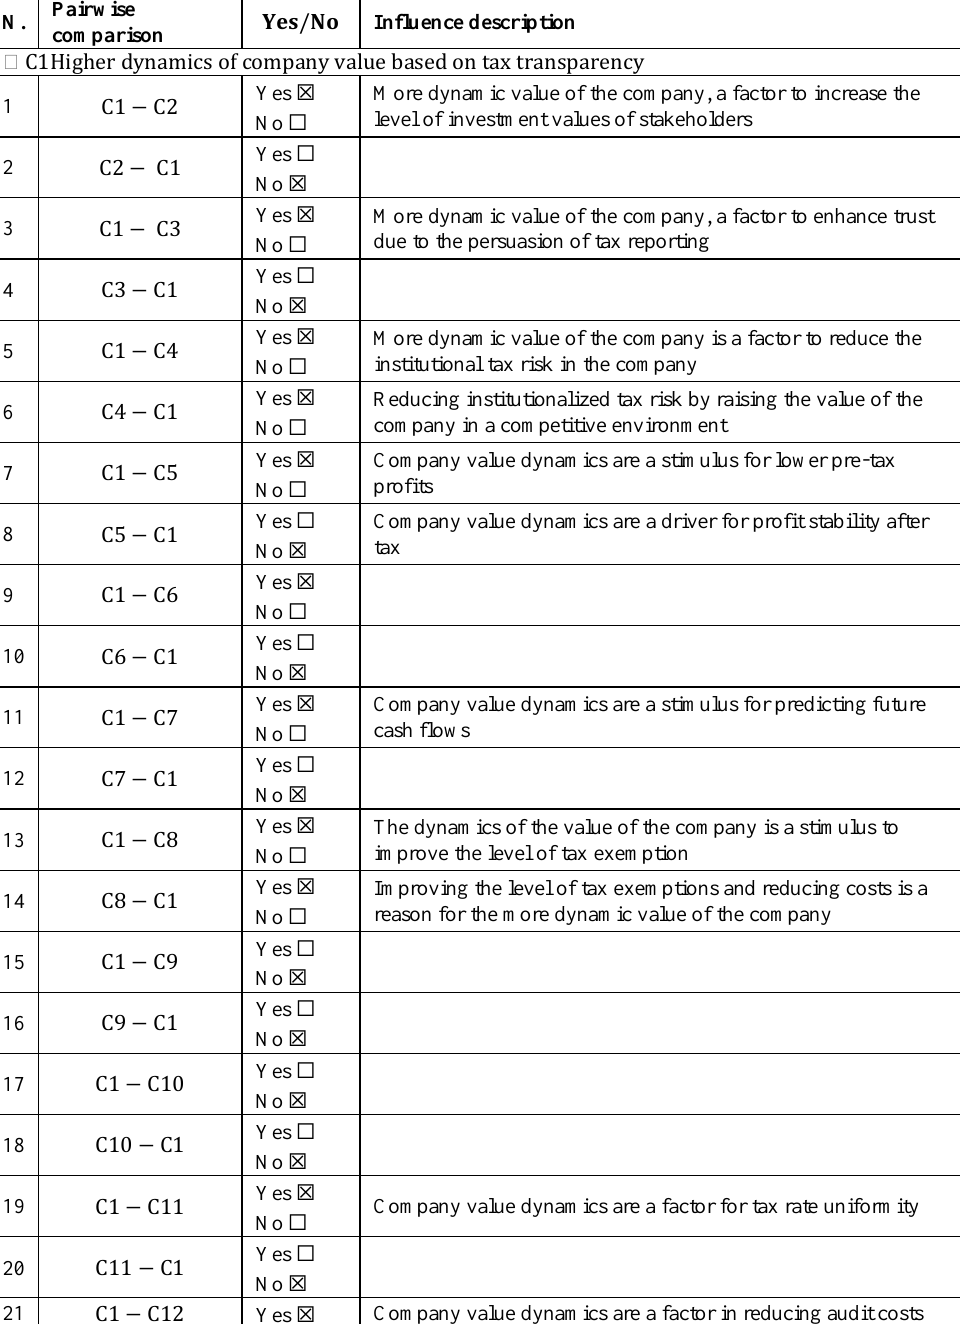
Table 9. Pairwise comparison between propositions based on the form of the matrix